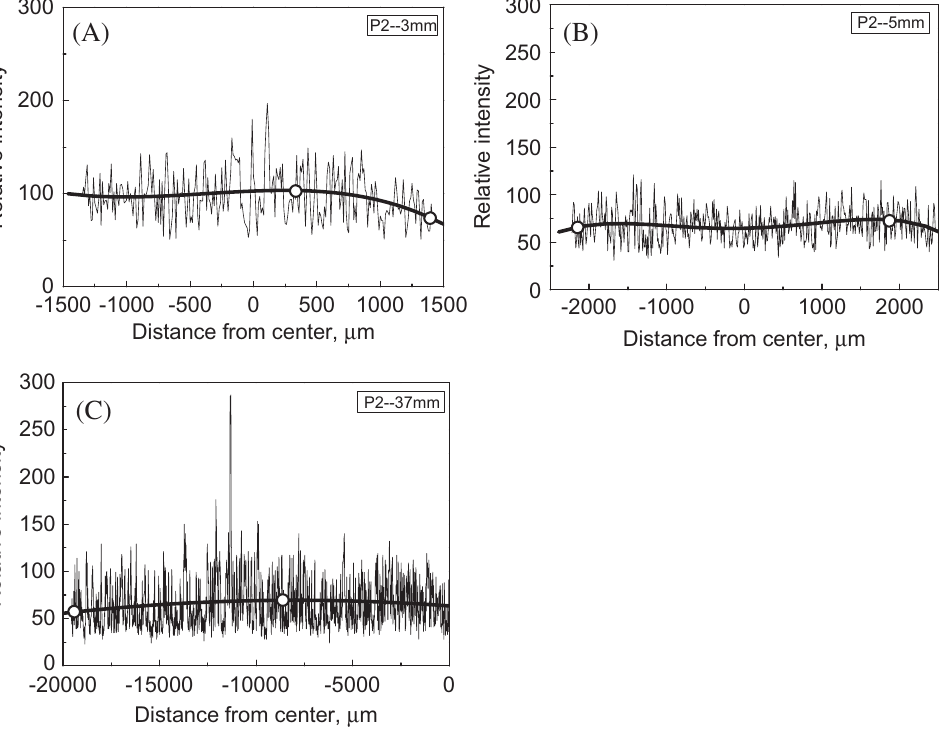
Figure 7: Distribution of P along the thickness direction in sample 2 at the thickness of 3mm, 5mm and 37mm. The last figure shows the test result from surface to